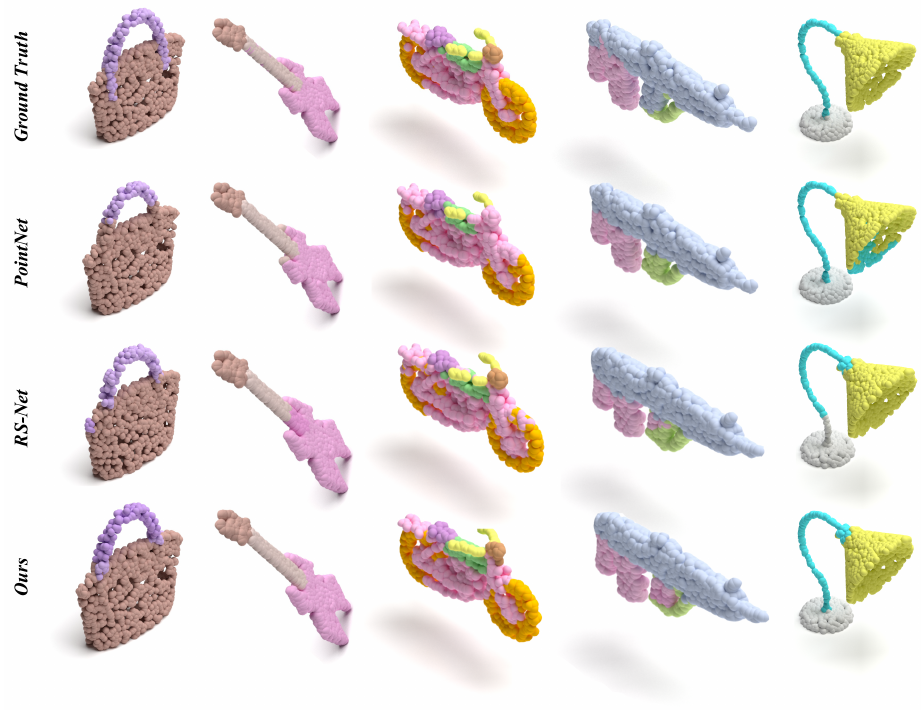
Figure 3. Segmentations from ground truth, PointNet, RS-Net, and